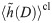
Fitness landscapes and selection strength measured for E. coli F3NW.A. Population growth curves. Green curve is for −Sm condition, and red for +Sm condition (the color correspondence is the same for all the following panels). Relative population size on the y-axis is the number of cells at each time point normalized by the number of cells at t = 0 min. The error bars in all panels are the standard deviations of three independent experiments. Growth rate difference became apparent only after t = 100 min. Hence, we set t0 = 100 min and t1 = 300 min in the following analyses. The numbers of cells at time t0 and t1 are shown in S2 Table. B-D. Comparison of population growth rate Λ (B), chronological mean lineage fitness 〈h˜(D)〉cl (C), and selection strength for division count S[D] (D), between −Sm and +Sm conditions. p-values by t-test are 0.036, 0.077, and 0.34, respectively (n = 4). E-G. Fitness landscapes h(x) (upper panels) and chronological distributions Pcl(x) (lower panels) for elongation rate λ¯τ (E), protein production rate p¯τ (F), and protein concentration c¯τ (G). H. Selection strengths. We compared selection strengths λτ¯, p¯τ, and c¯τ between −Sm and +Sm conditions, finding no statistically significant differences for all the phenotypes. The p-values are 0.12 for λ¯τ, 0.25 for p¯τ, and 0.48 for c¯τ, respectively (n = 4). I. Relative selection strengths. Again, no statistically significant differences were found. The p-values are 0.057 for λ¯τ, 0.27 for p¯τ, and 0.69 for c¯τ, respectively (n = 4). J. Relationship between relative selection strength and squared correlation coefficient between h˜(D) and h(x), where x=λ¯τ, p¯τ, or c¯τ. The correlation coefficients were evaluated by both chronological and retrospective probabilities.